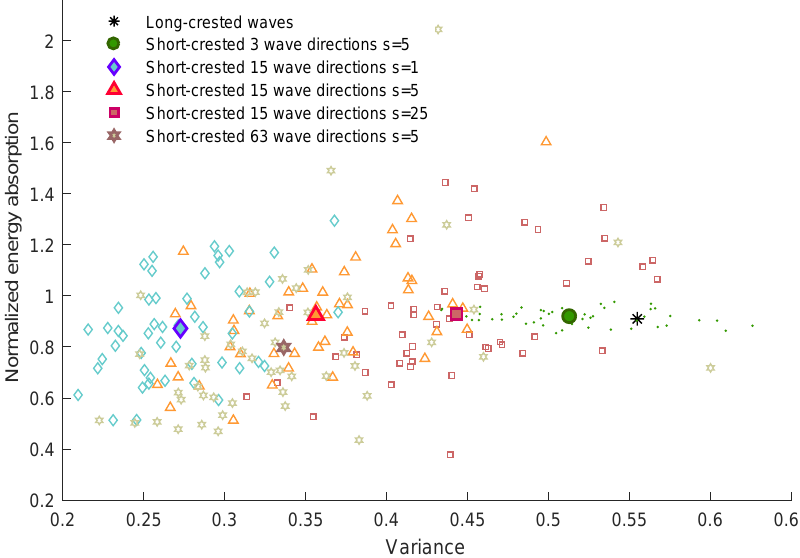
Figure 10. Performance of short-crested waves with different spreading parameters and number of wave directions, as compared to performance in long-crested waves. The variance (measure of the power fluctuations) and the normalized energy absorption of the park are shown. All 50 of the simulations with different random phases are shown as small unfilled markers, whereas the mean values are shown as larger filled